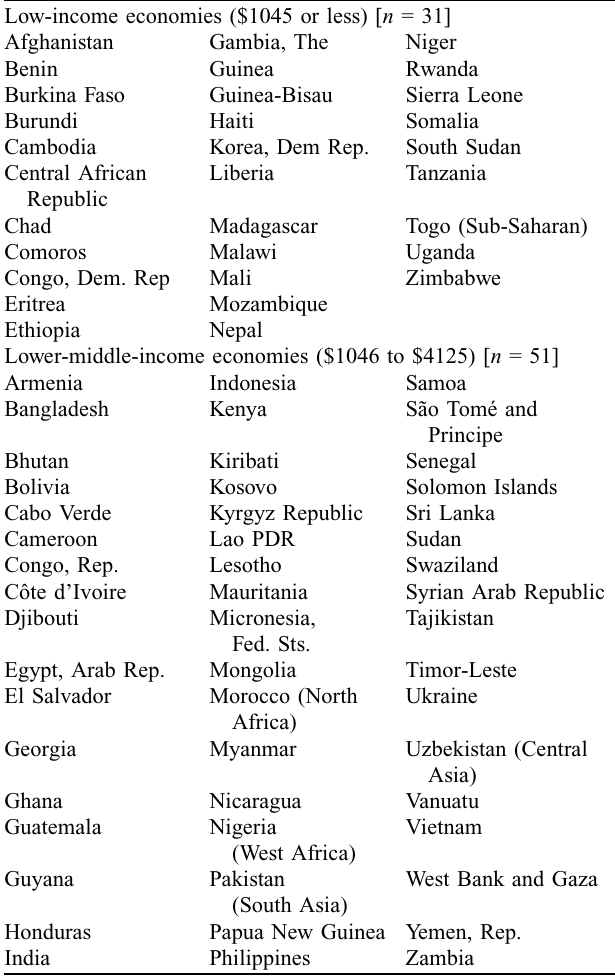
Table 1. Countries with low-income or lower-middle-income economies as defined by The World Bank. Table adapted